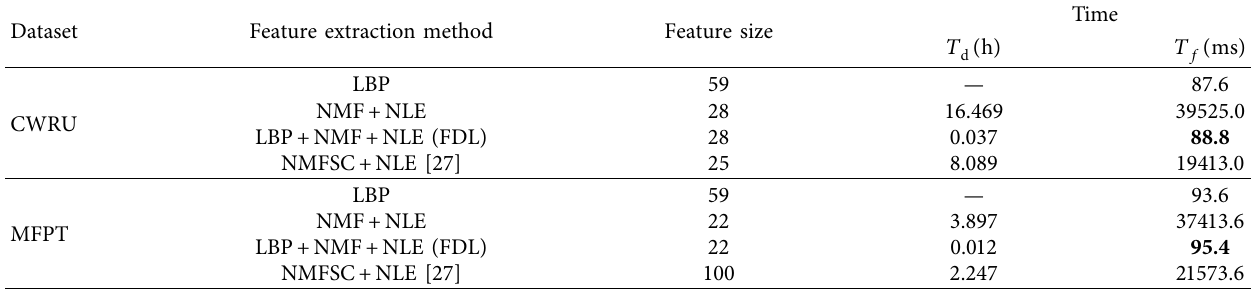
Table 5: Time taken by different feature extraction methods.